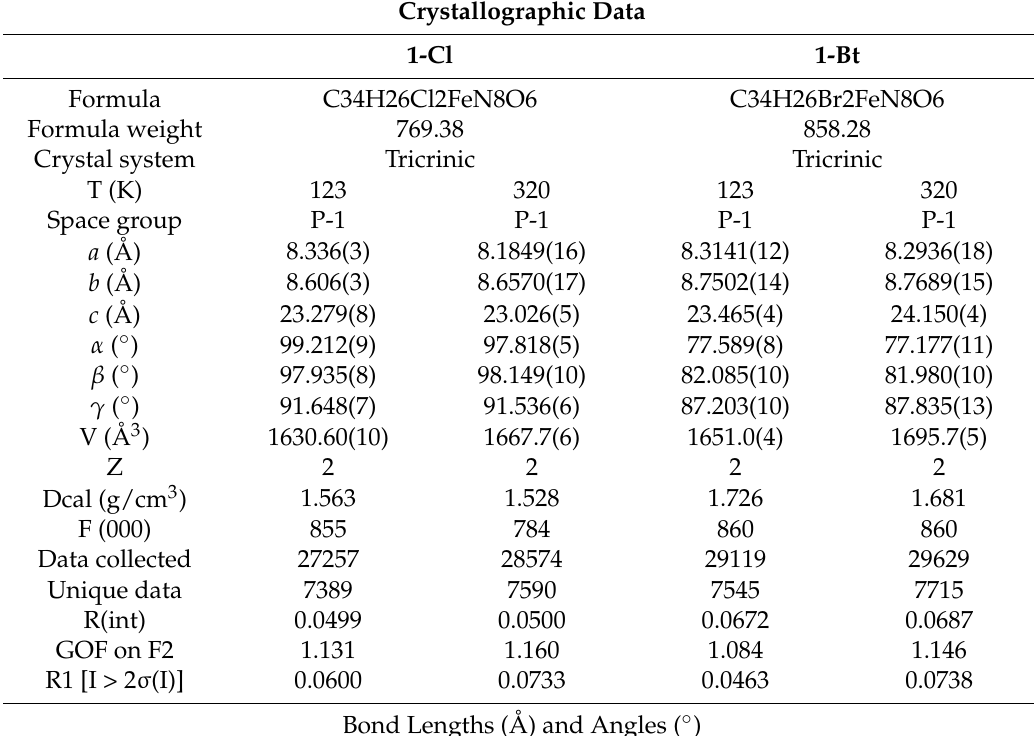
Table 1. Crystallographic data and coordination distances and angles around Fe(II) and the proton donor and acceptor sites, and the hydrogen bond geometry for 1-Cl and 1-Br at 123 K and 320